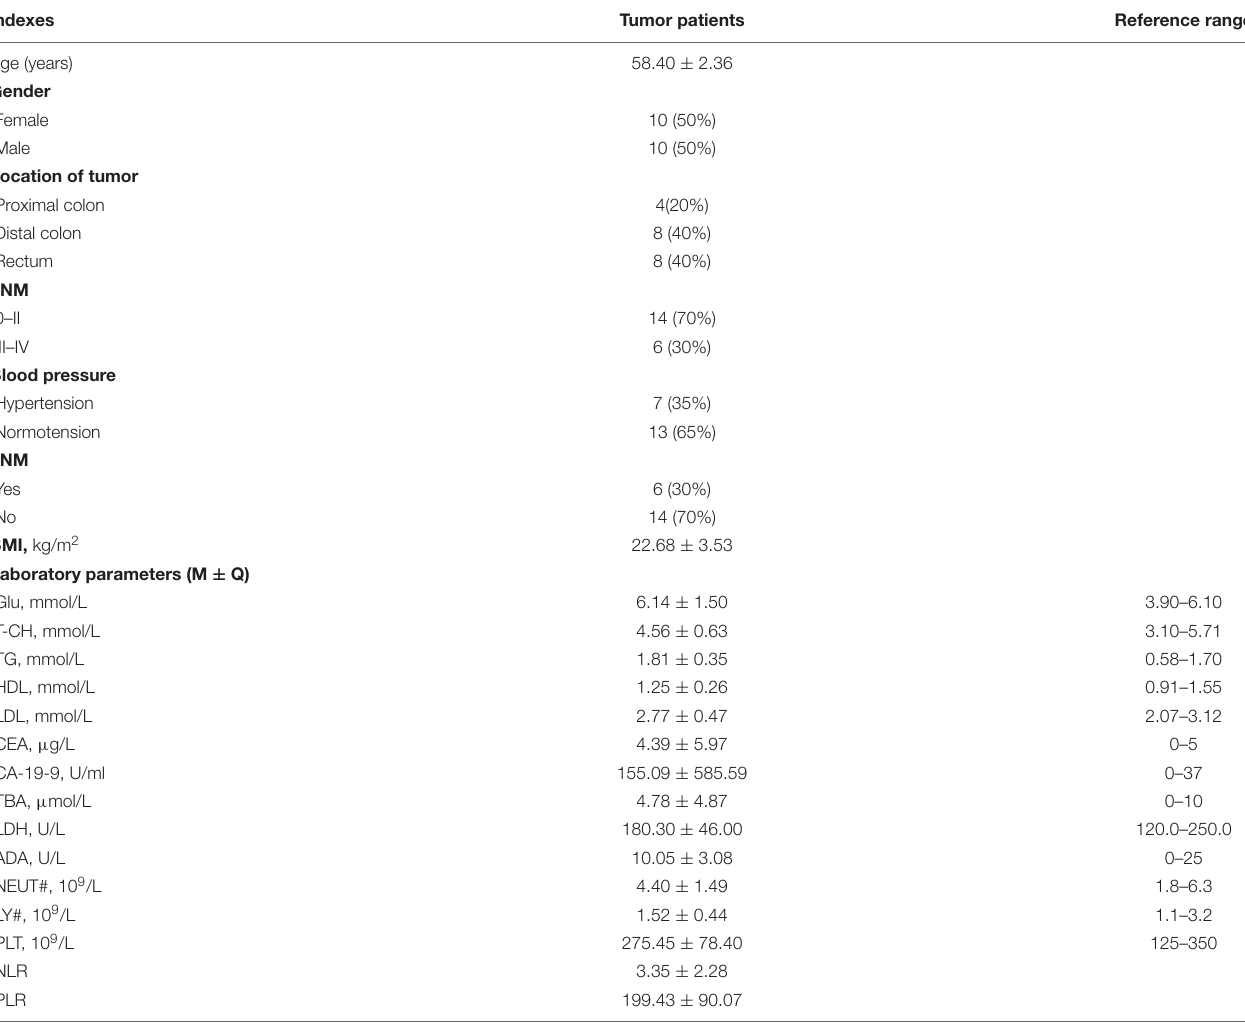
TABLE 1 | Clinical characteristics of